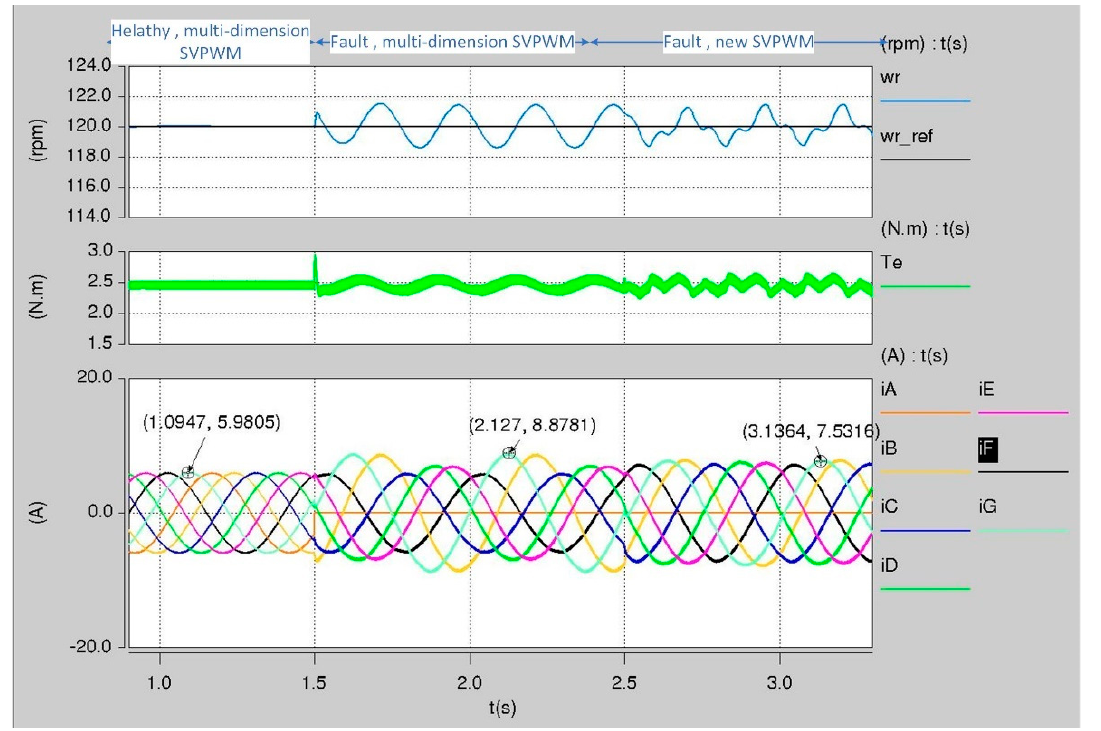
Figure 13. Simulation results of using the new SVPWM technique for the seven ‐ phase motor drive after losing phase ‘A’.